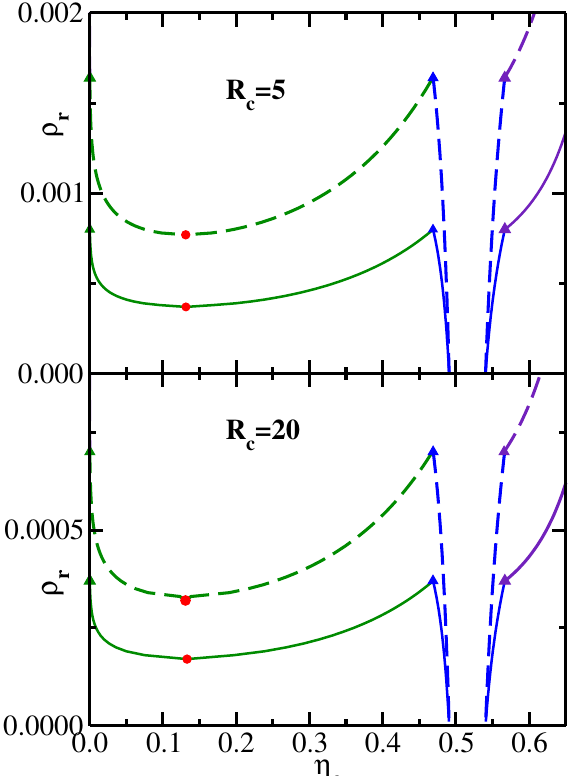
Figure 2. Phase boundaries for an effective one-component colloidal system in the reservoir represen- tation in the variables η c – ρ r . Green lines denote the liquid–vapor phase boundary, blue lines mark the liquid–solid phase boundary, and purple lines correspond to the vapor–solid phase boundary. Red circles mark the location of the liquid–vapor critical points, and the triangles denote the vapor– liquid–solid triple point coexistence. Upper panel: solid lines correspond to the polymeric chains with ( N = 40, κ = 25.1); dashed lines correspond to the polymeric chains with ( N = 96, κ = 3.5); the colloid radius is R c = 5. Lower panel: solid lines correspond to the polymeric chains with ( N = 48, κ = 11.5); dashed lines correspond to the polymeric chains with ( N = 96, κ = 3.5); the colloid radius is R c =